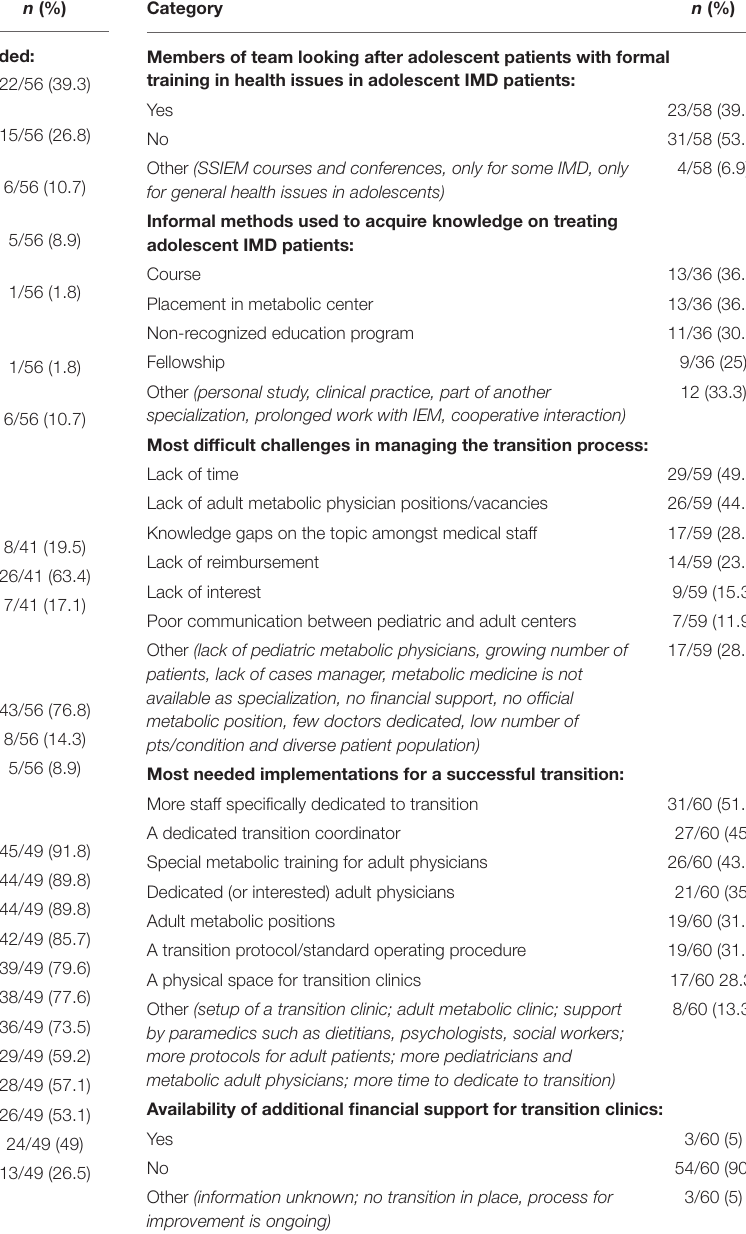
TABLE 3 | Information exchanged among physicians for/during transition. Category